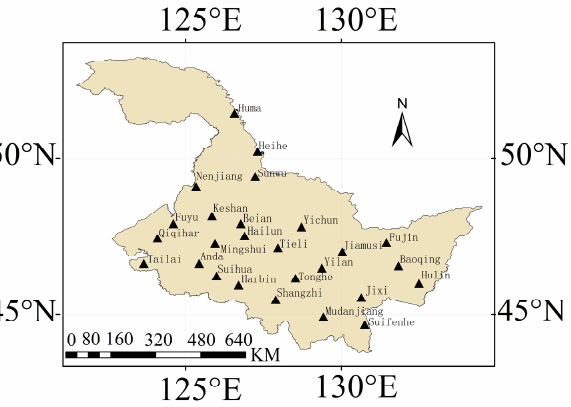
Figure 1. Map of the study area and distribution of meteorological stations in Heilongjiang Province.